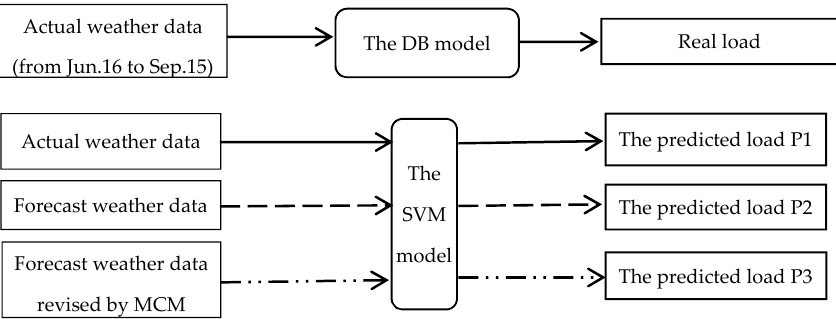
Figure 2. The framework of the case study.